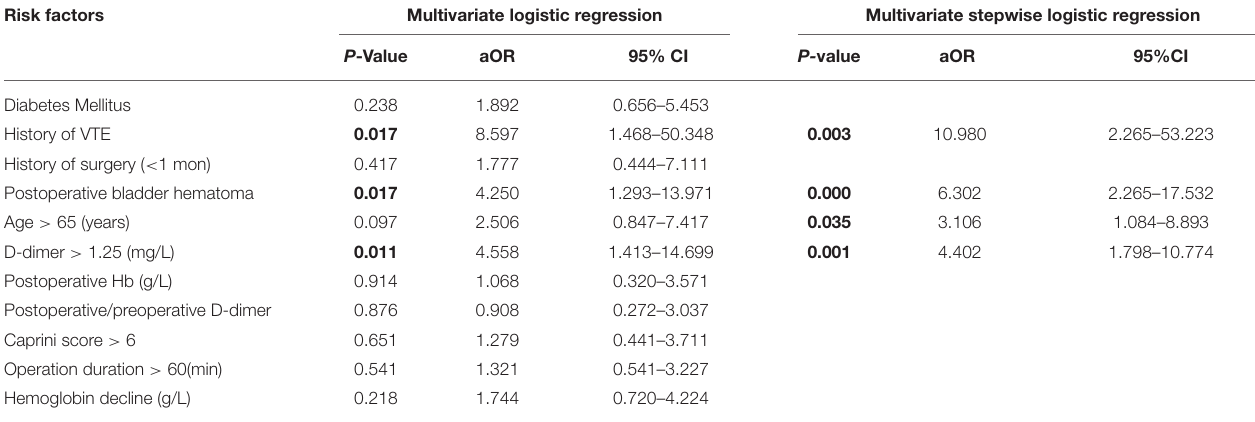
TABLE 3 | Multivariate and multivariate stepwise logistic regression analysis of risk factors associated with VTE following TURP.